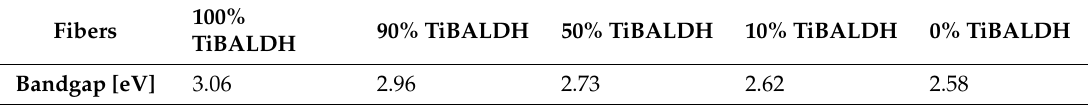
Figure 7. Di ff use reflectance UV-Vis spectra: ( a ) 100% TiBALDH, ( b ) 90% TiBALDH ( c ) 50% TiBALDH, ( d ) 10% TiBALDH, and ( e ) 0% TiBALDH. Table 2. Bandgap values for the annealed fibers.